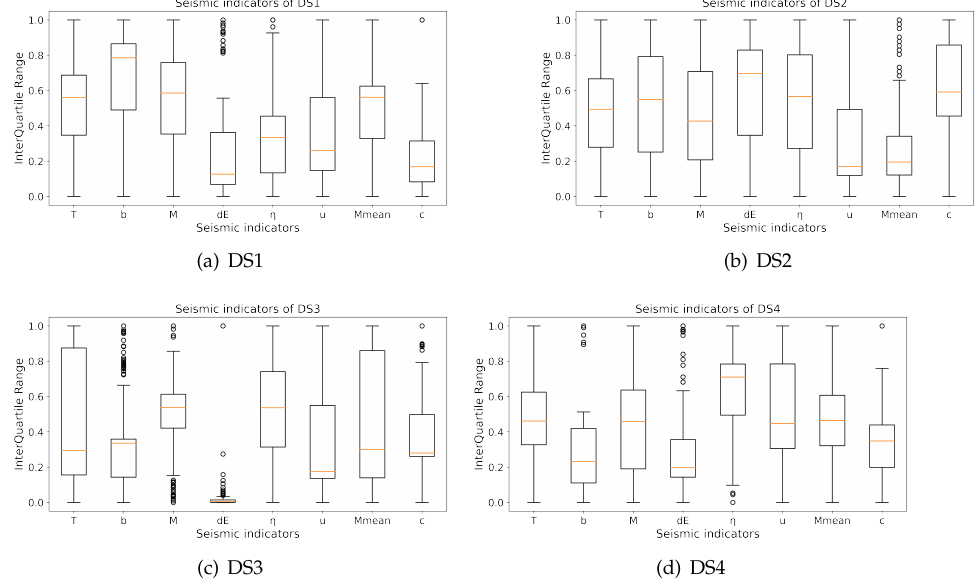
Figure 2. Box plot of the eight seismic indicators distribution of each